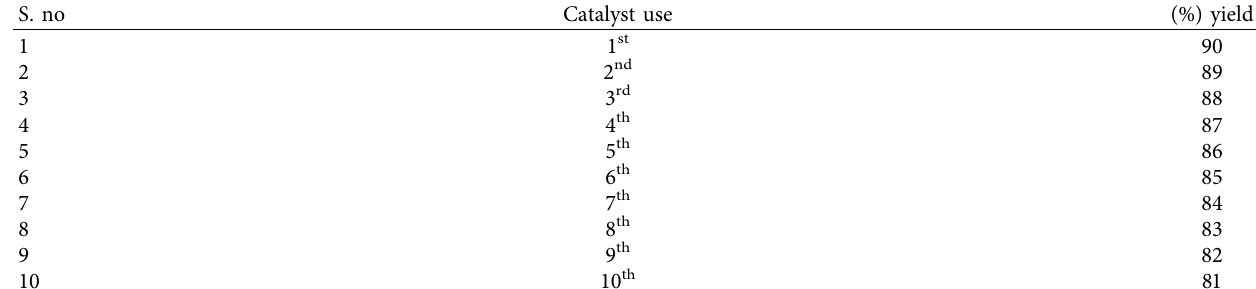
Table 1: Catalyst recyclability.